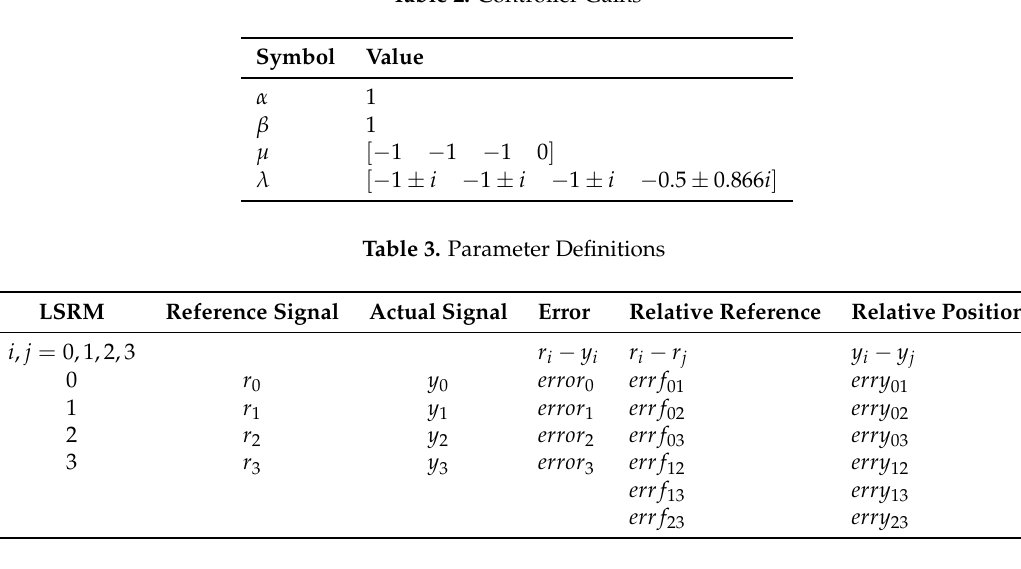
Table 2. Controller Gains